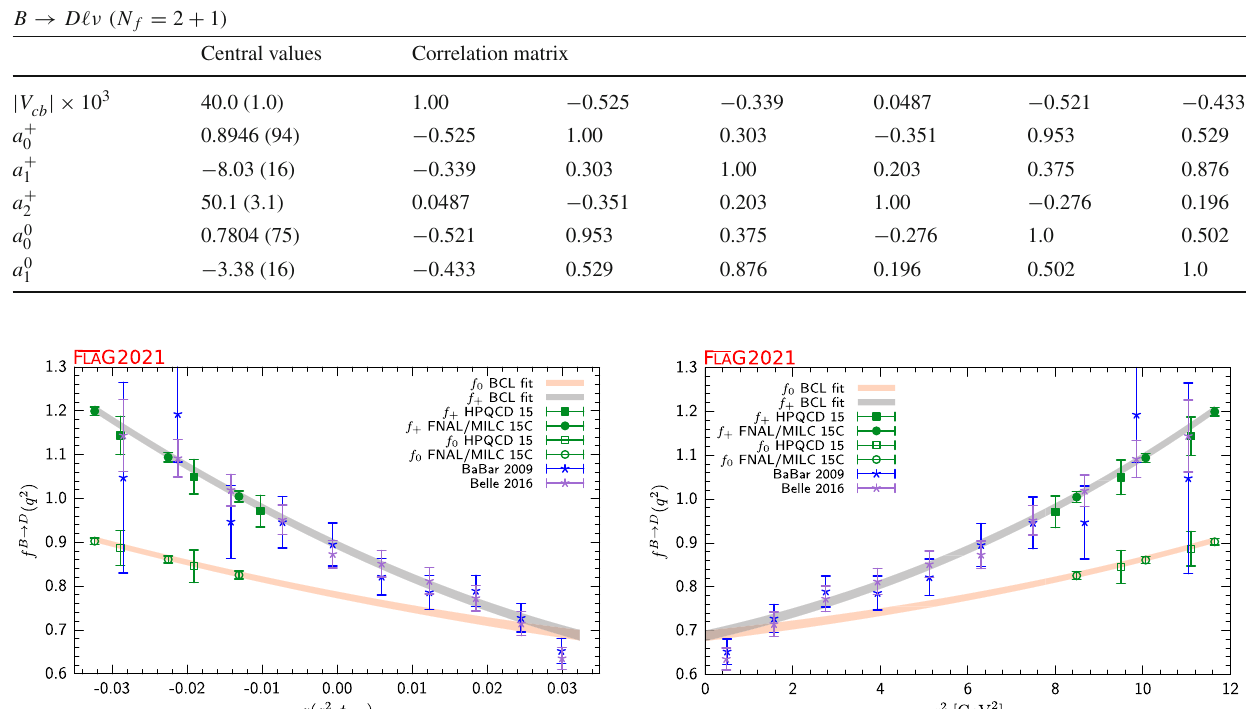
Table 58 | V cb | , coefficients for the N + = N 0 z -expansion of the B → D form factors f + and f 0 , and their correlation matrix. The coefficient a 0 is fixed by the f + ( q 2 = 0 ) = f 0 ( q 2 = 0 ) constrain. The chi-square per degree offreedom is χ 2 / dof = 20 . 0 / 25 = 0 . 80. The lattice calculations that enter this fit are taken from FNAL/MILC [606] and HPQCD [607]. The experimental inputs are taken from BaBar [667] and Belle [666]